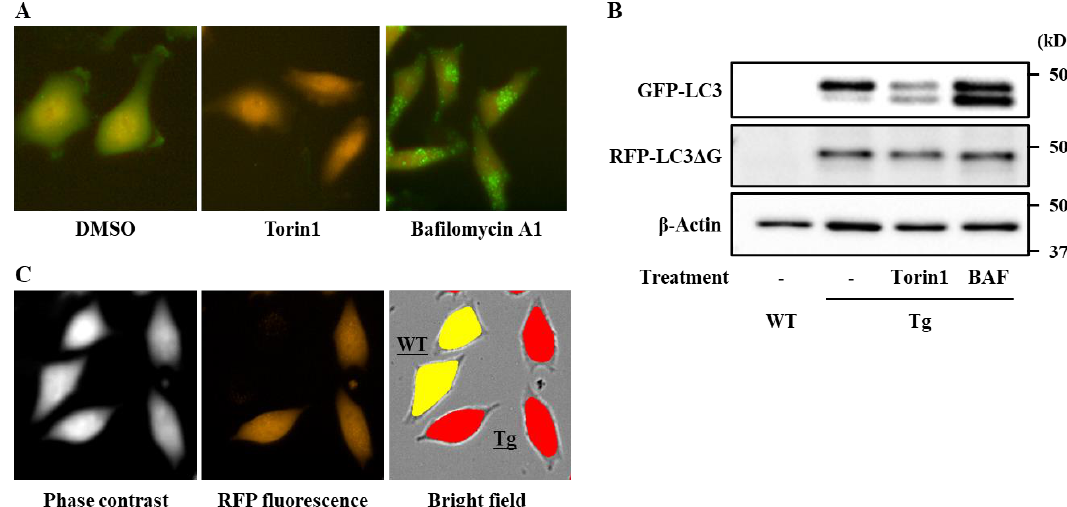
Figure 1. Establishment of an assay system for detecting cellular autophagy flux. HeLa cells stably expressing green fluorescent protein (GFP)-microtubule-associated protein light chain 3 (LC3)-red fluorescent protein (RFP)-LC3 ∆ G were treated with Torin1 (250 nM) or bafilomycin A1 (BAF; 100 nM) for 12 h ( A , B ). Probe expression was detected by fluoroimaging ( A ) and western blotting using antibodies against GFP or RFP ( B ); β -Actin was used as an internal control. Using an Operetta high-content imaging system, co-cultured transgenic and wild-type HeLa cells were distinguished by digital phase-contrast and RFP fluorescence (yellow, wild-type; red, transgenic); the net fluorescence derived from the probe was calculated to obtain the GFP / RFP ratio ( C